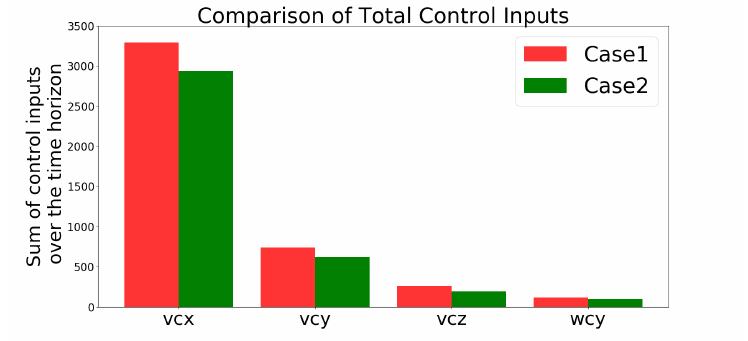
Figure 13. Simulation 1: comparison of the total amount of control